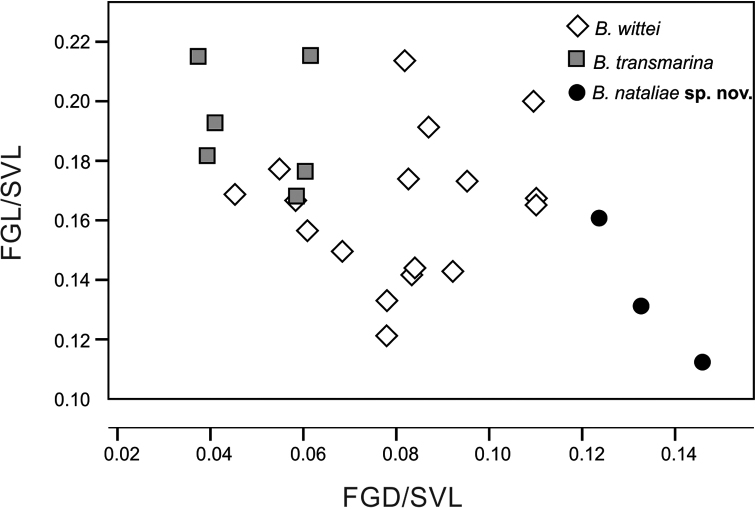
Scatterplot of relative femoral gland length (FGL/SVL ratio) and the relative distance between the inner edges of the femoral glands (FGD/SVL) in the two new species from Mayotte and their sister taxon Blommersia
wittei from Madagascar. Measurements are based on Table 1; and for B.
wittei on Vences et al. (2010) and Pabijan et al. (2011). Note the intermediate position of B.
wittei between B.
transmarina and B.
nataliae sp. nov.